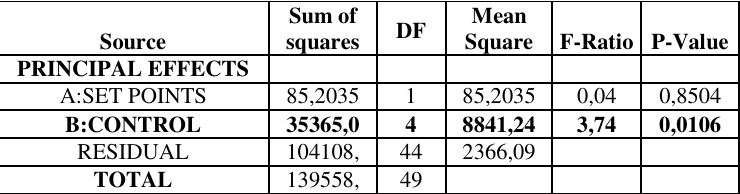
Table 3 ( B ). Analysis of Variance for EC (sum of squares type III).